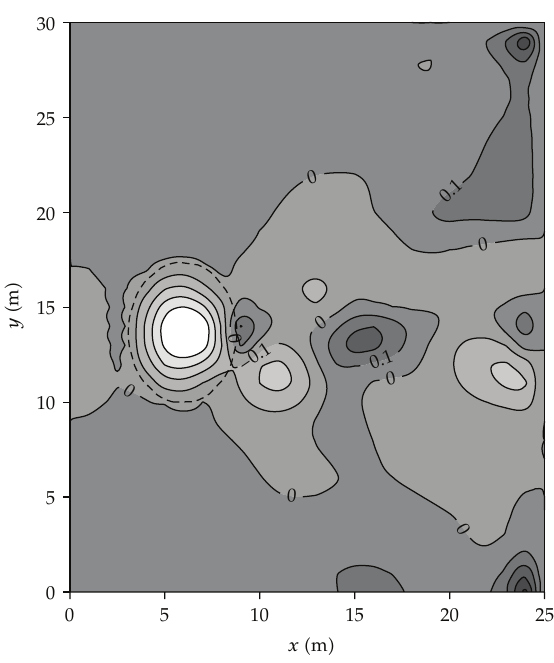
Figure 7: The horizontal distribution of the calculated mean water level after the third two-way iteration.